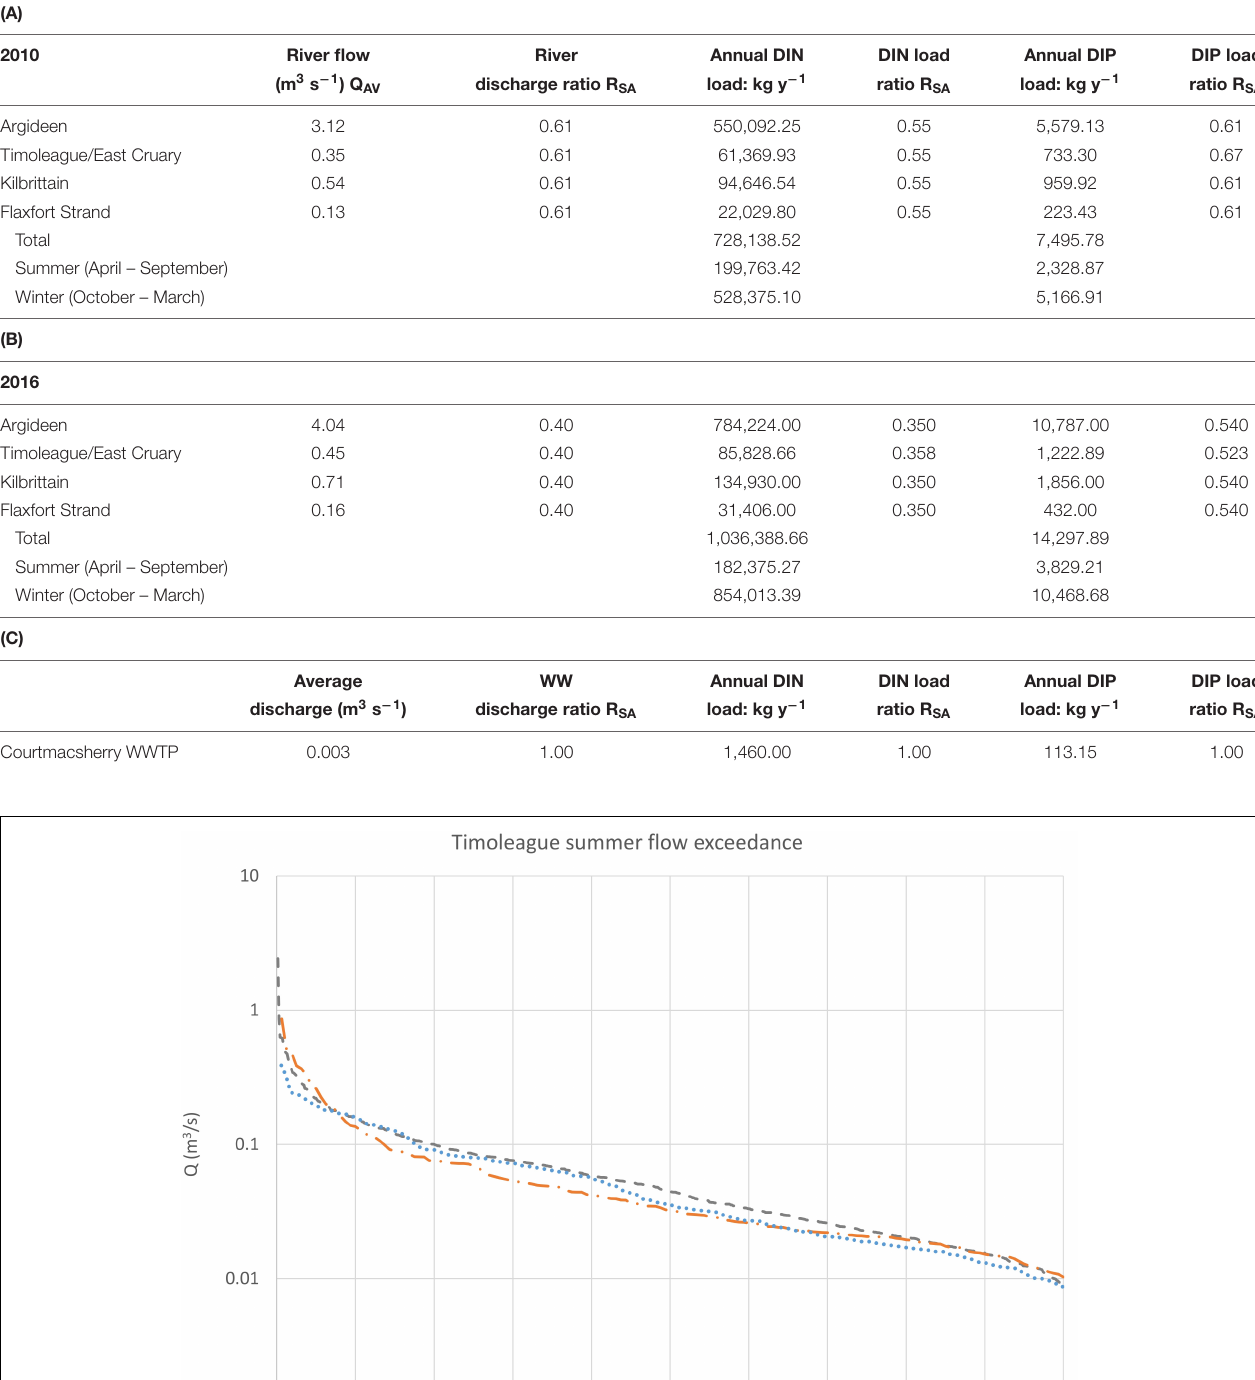
TABLE 2 | River discharge and nutrient loading data for (A) 2010 and (B) 2016, and (C) effluent characteristics from the existing Courtmacsherry wastewater treatment which discharges to the lower Argideen Estuary.